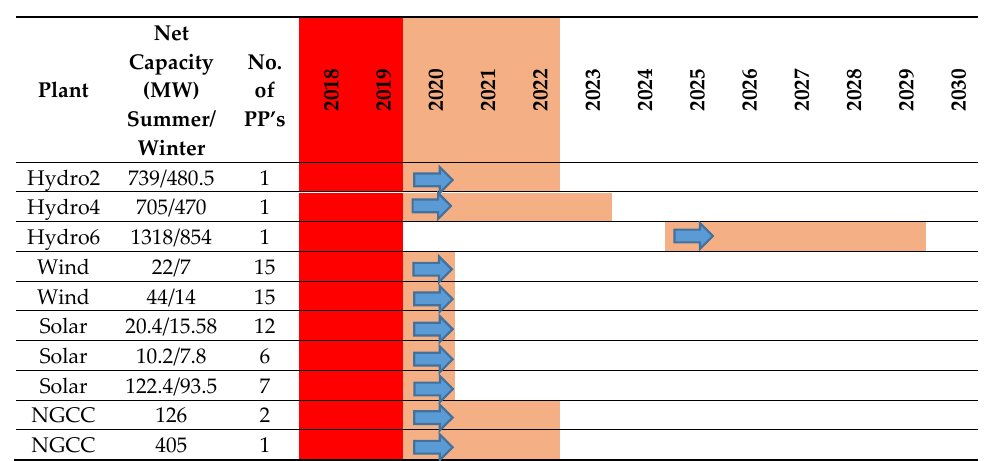
Table A5. Details of the Plants Installation under Capacity Expansion: Low GDP Fuel Balancing (5–50% Mitigation).